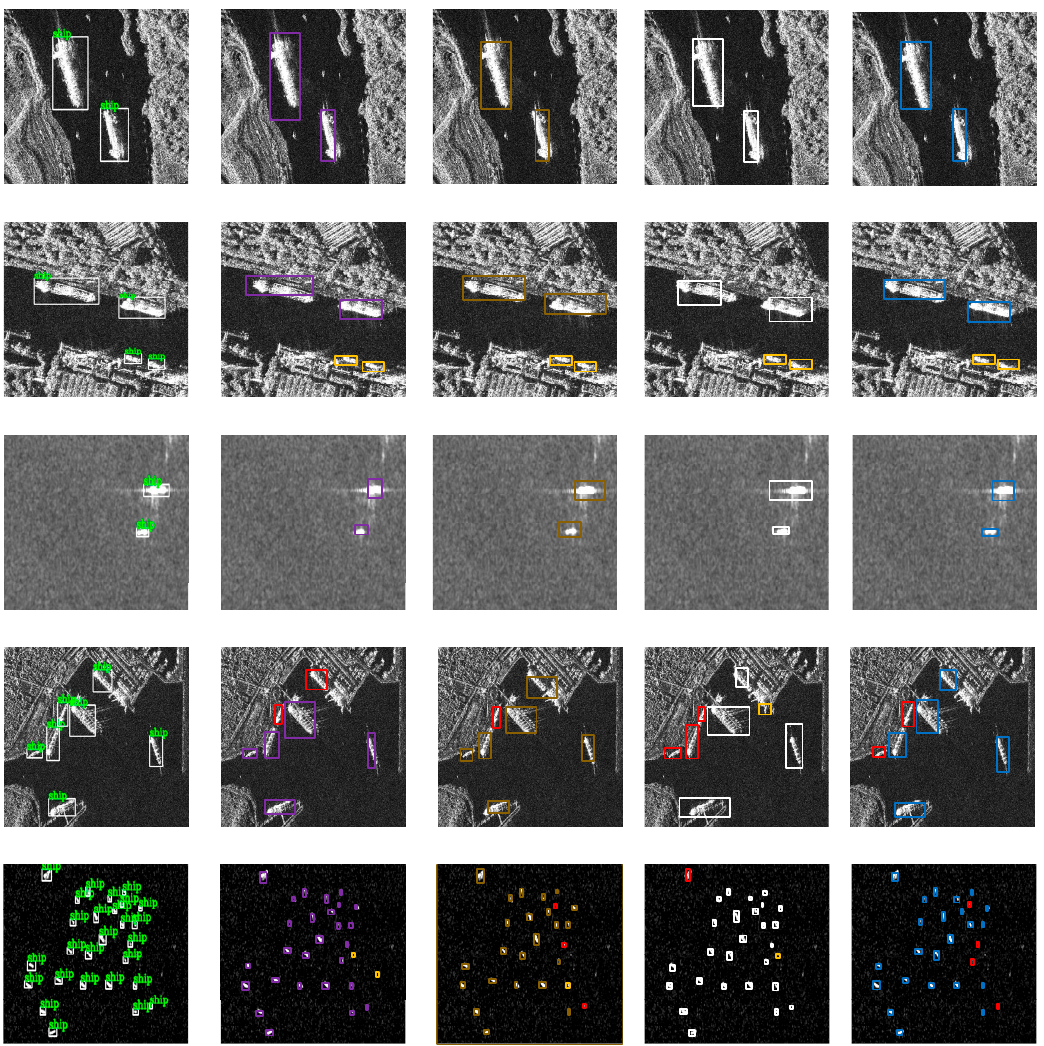
ff erent methods. ( a ) Ground truth; ( b ) faster-regions Change 4 Figure 17. The ship detection results of di convolutional neural network (Faster R-CNN); ( c ) you only look once (YOLO); ( d ) single shot multi-box detector (SSD); ( e ) G-CNN. The miss-detection is marked in red and the false alarm is marked in yellow. Therefore, we also studied the e ff ect of a pre-processing refined lee filter on high-noise